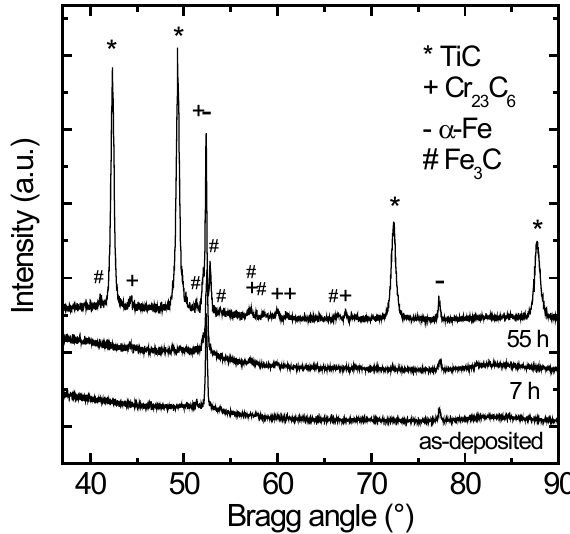
Figure 1. Grazing incidence X-ray diffraction (GI-XRD) patterns of (Ti in the as-deposited state and after annealing at 700 °C for different annealing times. The precipitated phases of type TiC and Cr from the steel